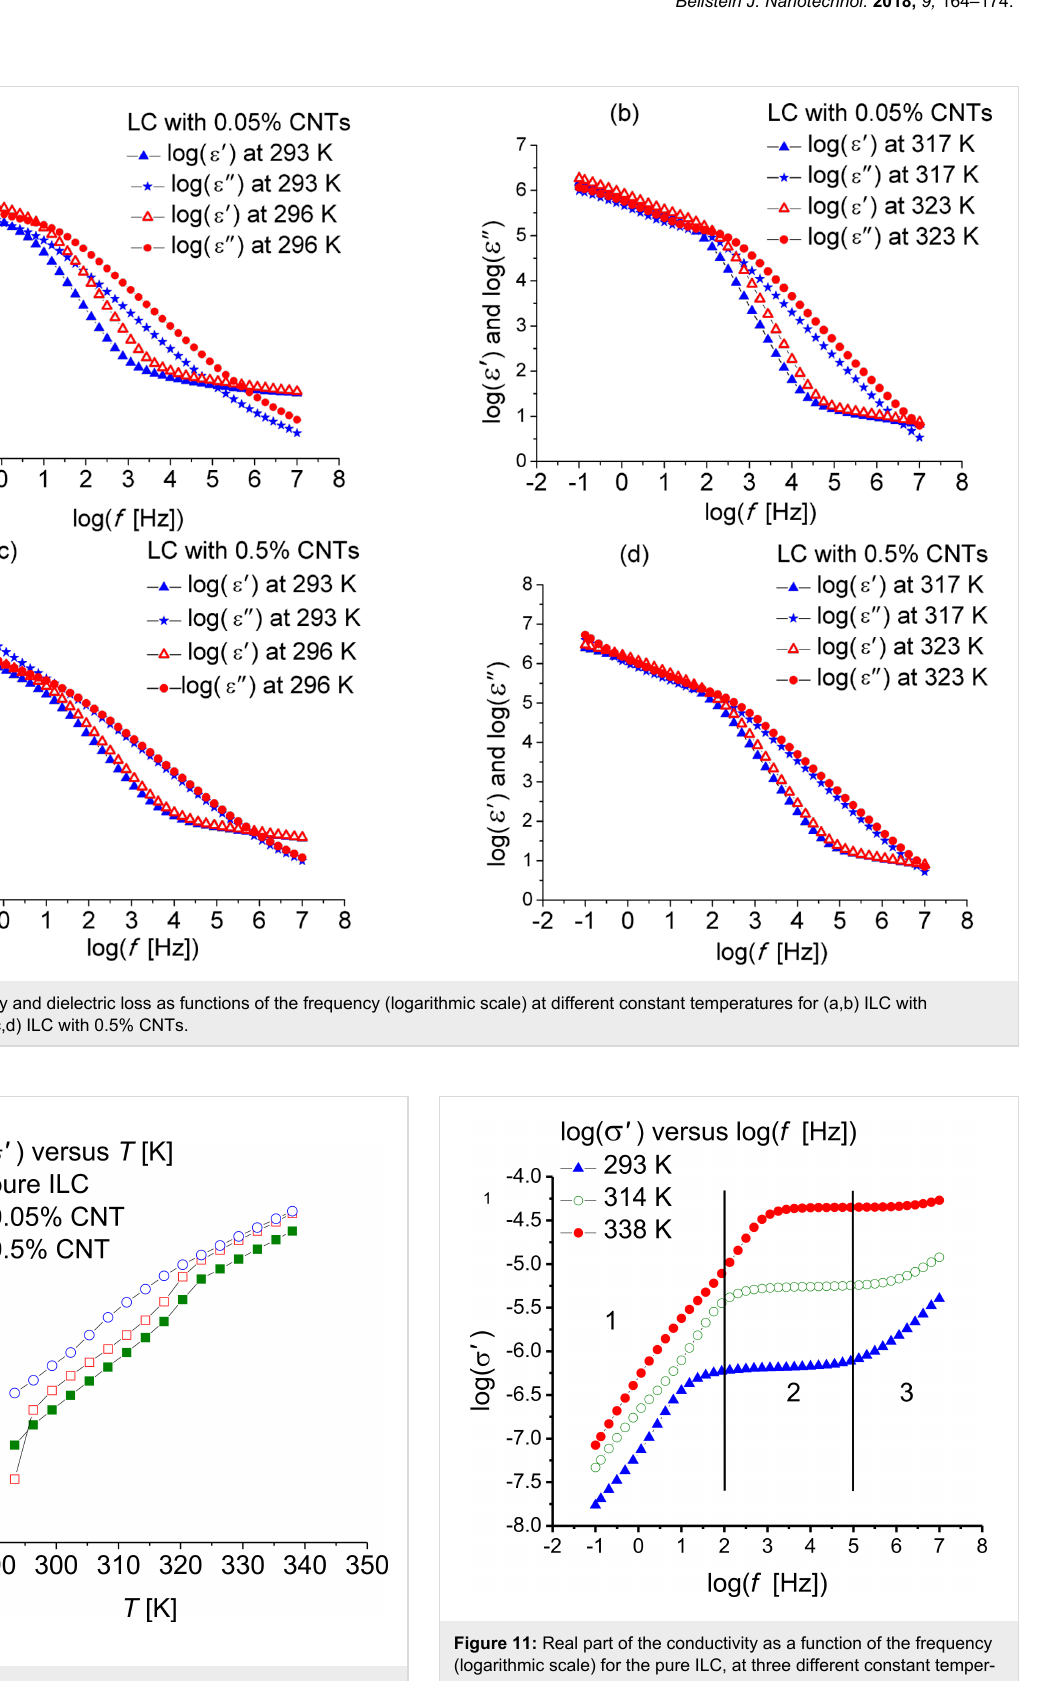
Figure 10: Real part of the conductivity versus temperature for pure ILC and ILC doped with CNTs, at 10 kHz.